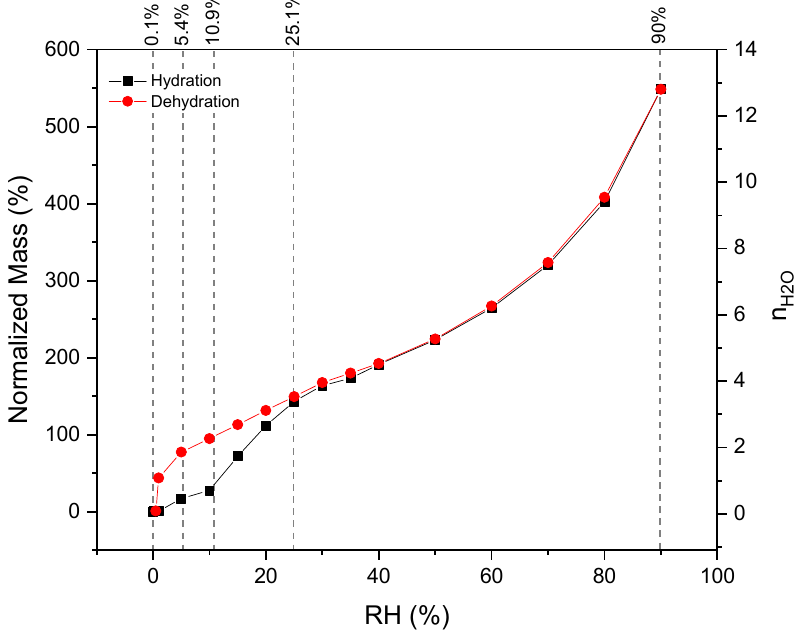
Figure 5. Water vapor hydration/dehydration isotherms (DVS) of the LiCl composite foams at 30 ◦ C. While increasing the RH in the chamber, the hydration conditions became more favorable for the reaction to proceed and the mass uptake progressively increased. More specifically, the material exhibited a small water uptake at low partial pressure (below 1% RH). At intermediate RH values, between 5 and 25%, a quasi-linear water uptake from ~17 to ~143 wt.% was observed. Finally, above an RH of 25%, a notable mass uptake from ~143 up to 550 wt.% was observed. Taking into account the hydration reaction of LiCl salt, which is (cid:29) LiCl · H + H LiCl ( 2 O ( g ) 2 O ( s ) s ) and the molecular mass of both reagents and products (M LiCl = 42.39 g/mol, M LiCl · H2O = 60.41 g/mol), a theoretical mass uptake of 42.39% is expected when LiCl converts into its monohydrated phase. Hence, it is evident from the gravimetric profile that the full conversion of LiCl into its monohydrated phase occurs at an RH of between 10 and 15%. Above this value, the material is overhydrated and it reaches up to ~13 water molecules. The dehydrated LiCl can exist in the solid form at a low temperature below 20 ◦ C. Hence, the water intake over the monohydrated threshold at the experimental temperature of 30 ◦ C could be caused by the capillary condensation mechanism and the deliquescence phenomenon is expected to take